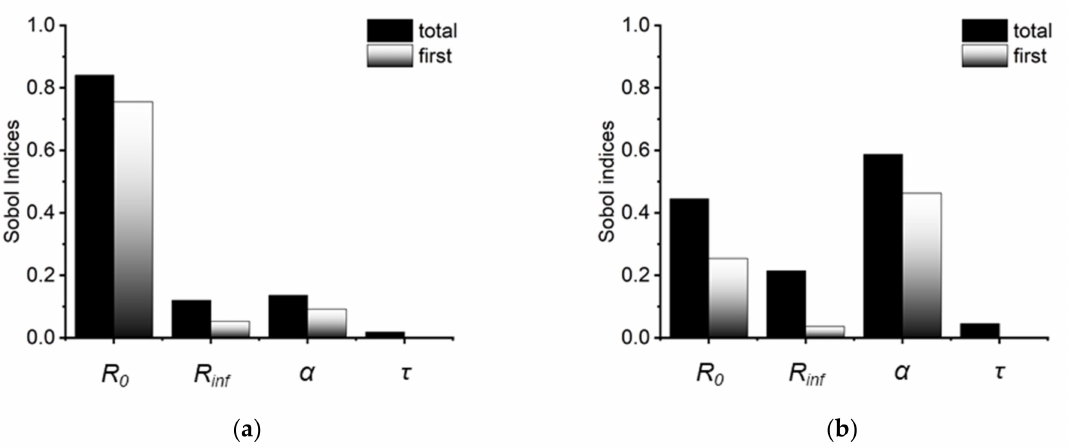
Figure 3. The first order and total Sobol indices of Cole parameters for the real part ( a ) and imaginary part ( b ) of the Cole impedance. Larger total Sobol indices than first order Sobol indices indicate interactions among the Cole